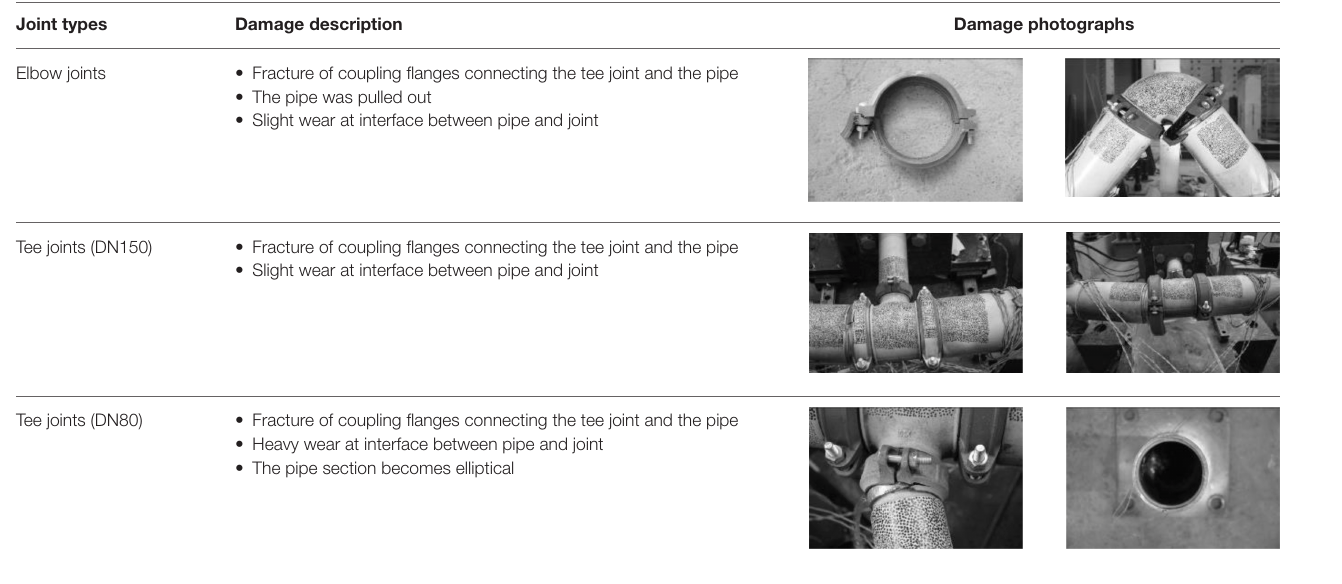
TABLE 1 | Observed physical damages of grooved fit joint